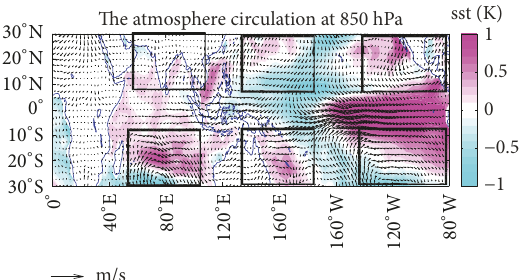
Figure 4: Composite wind field (arrows) and SST (color fill) at 850 hPa.